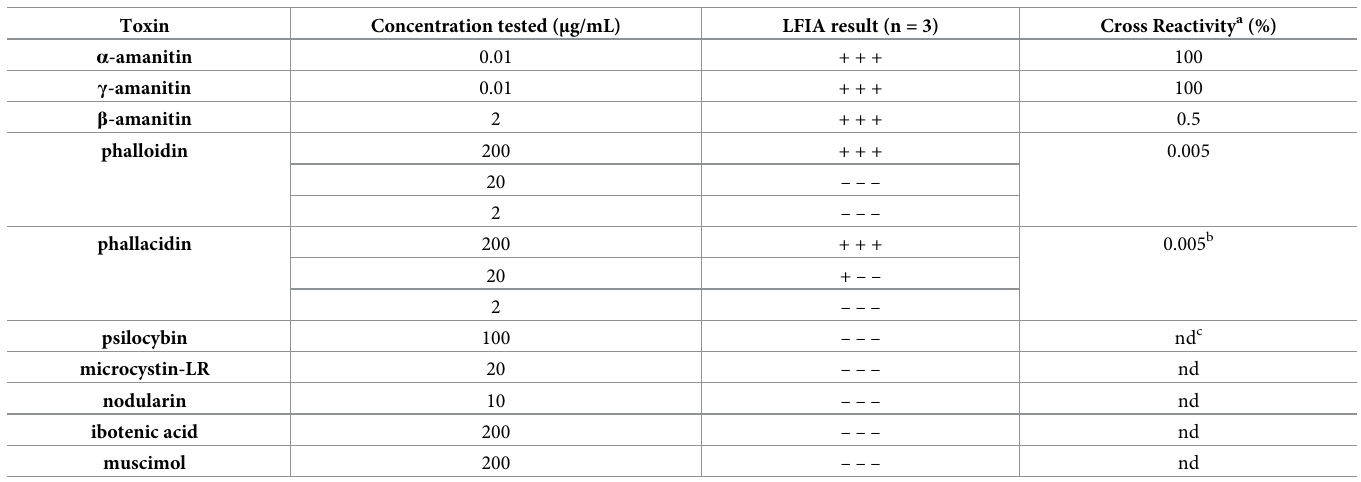
Table 1. LFIA test results for pure chemical toxin standards of chemicals from associated mushrooms or are other peptide toxins. Toxin Concentration tested ( μ